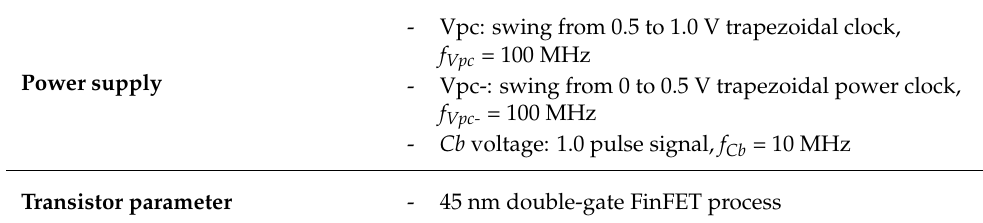
Table 1. Simulation conditions.